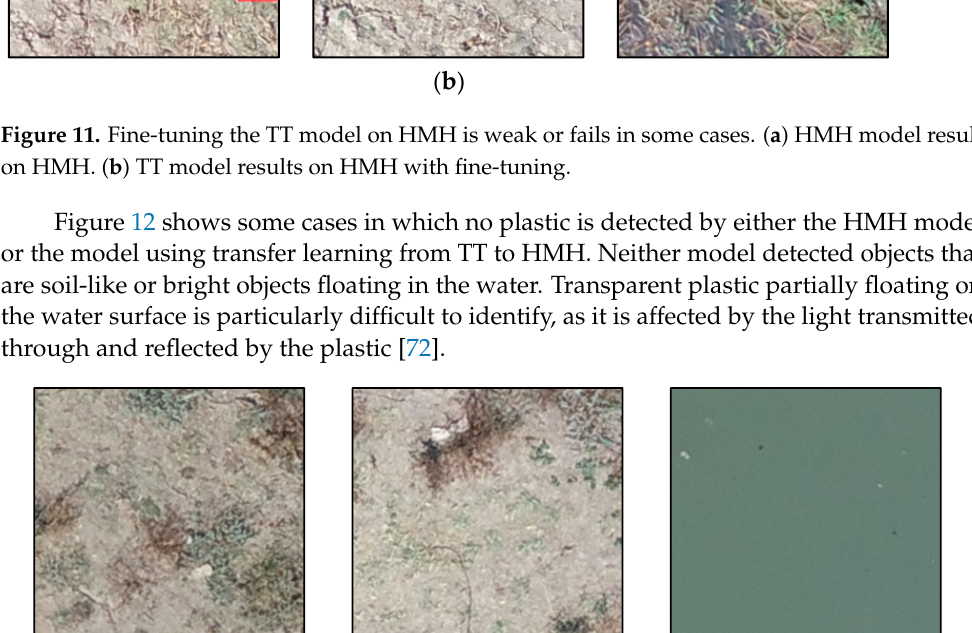
Figure 11. Fine-tuning the TT model on HMH is weak or fails in some cases. ( a ) HMH model result on HMH. ( b ) TT model results on HMH with fine-tuning.